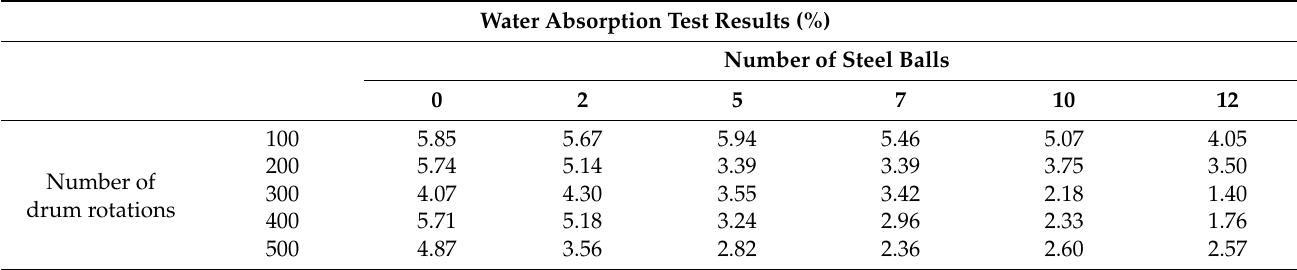
Table 2. The water absorption values of processed 4–11.2 mm RA after the application of BMM [21]. Water Absorption Test Results (%)